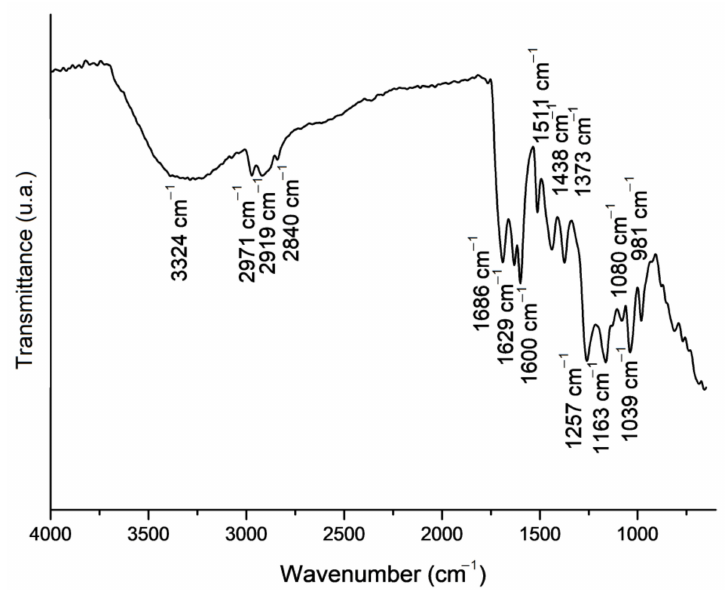
Figure 1. Fourier-Transform Infrared Spectroscopy bands related to the propolis